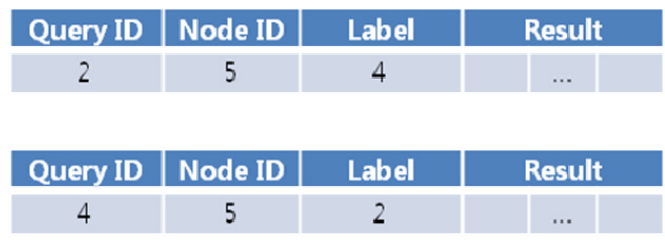
Figure 11. Two examples of response messages delivered to the Distributor. (a) is delivered to A2 and (b) is delivered to